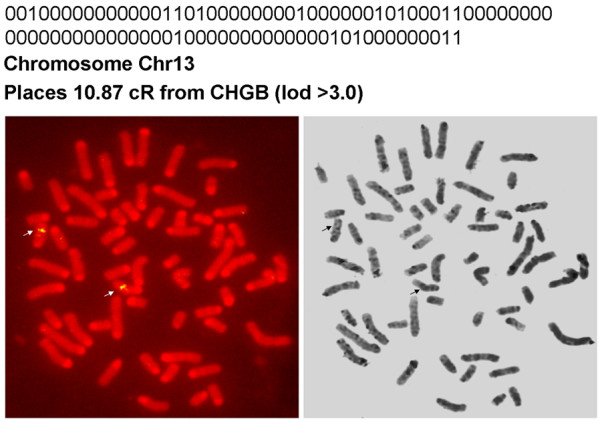
Chromosomal location of bovine RTEL. Bovine RTEL gene is mapped to chromosome 13 by radiation hybrid mapping (RH mapping) and fluorescence in situ hybridization (FISH). The numbers indicated the PCR results of RH mapping, 1 and 0 represent positive and negative signals respectively. RTEL was mapped to bovine chromosome 13, placed 10.87 cR from the CHGB mark (LOD>3.0). The FISH and G-banding results shown in the bottom further confirmed the RH mapping result, specific hybridization signals (arrows) were observed on homologous chromosomes 13q2.2 comparing to standard GTG-banded cattle karyotype.